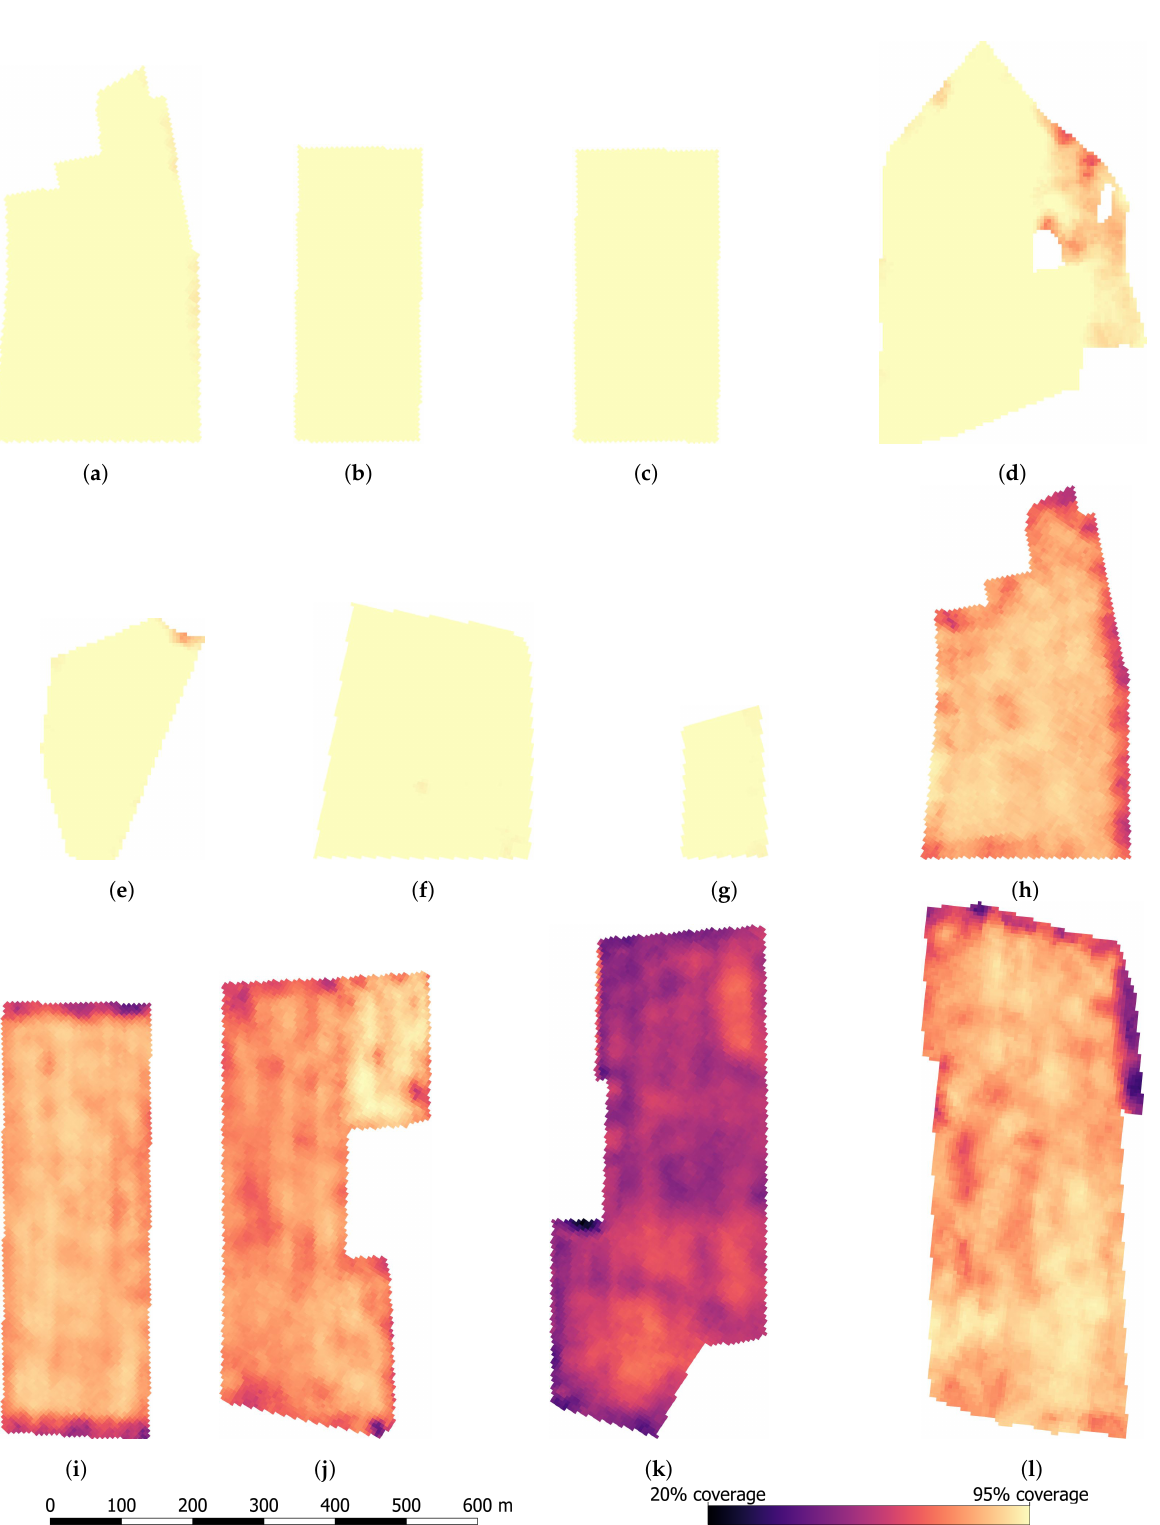
5 m interpolated ×